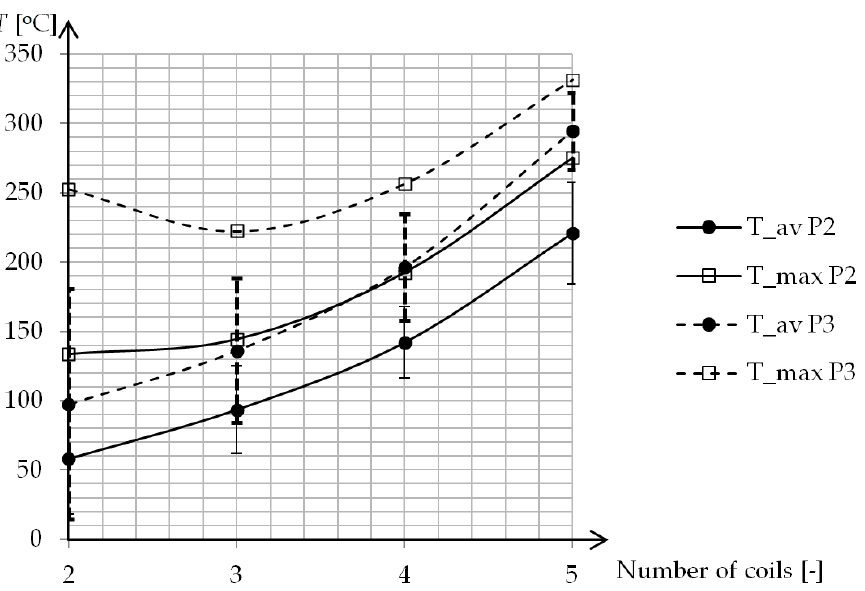
Figure 12. Average (T_av) and maximum (T_max) cavity surface temperature for different geome- tries.